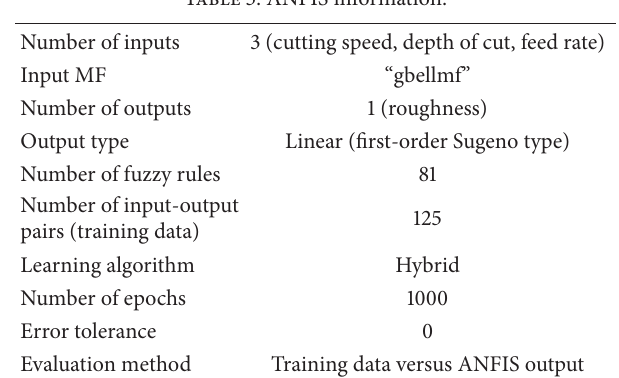
Table 5: ANFIS information.